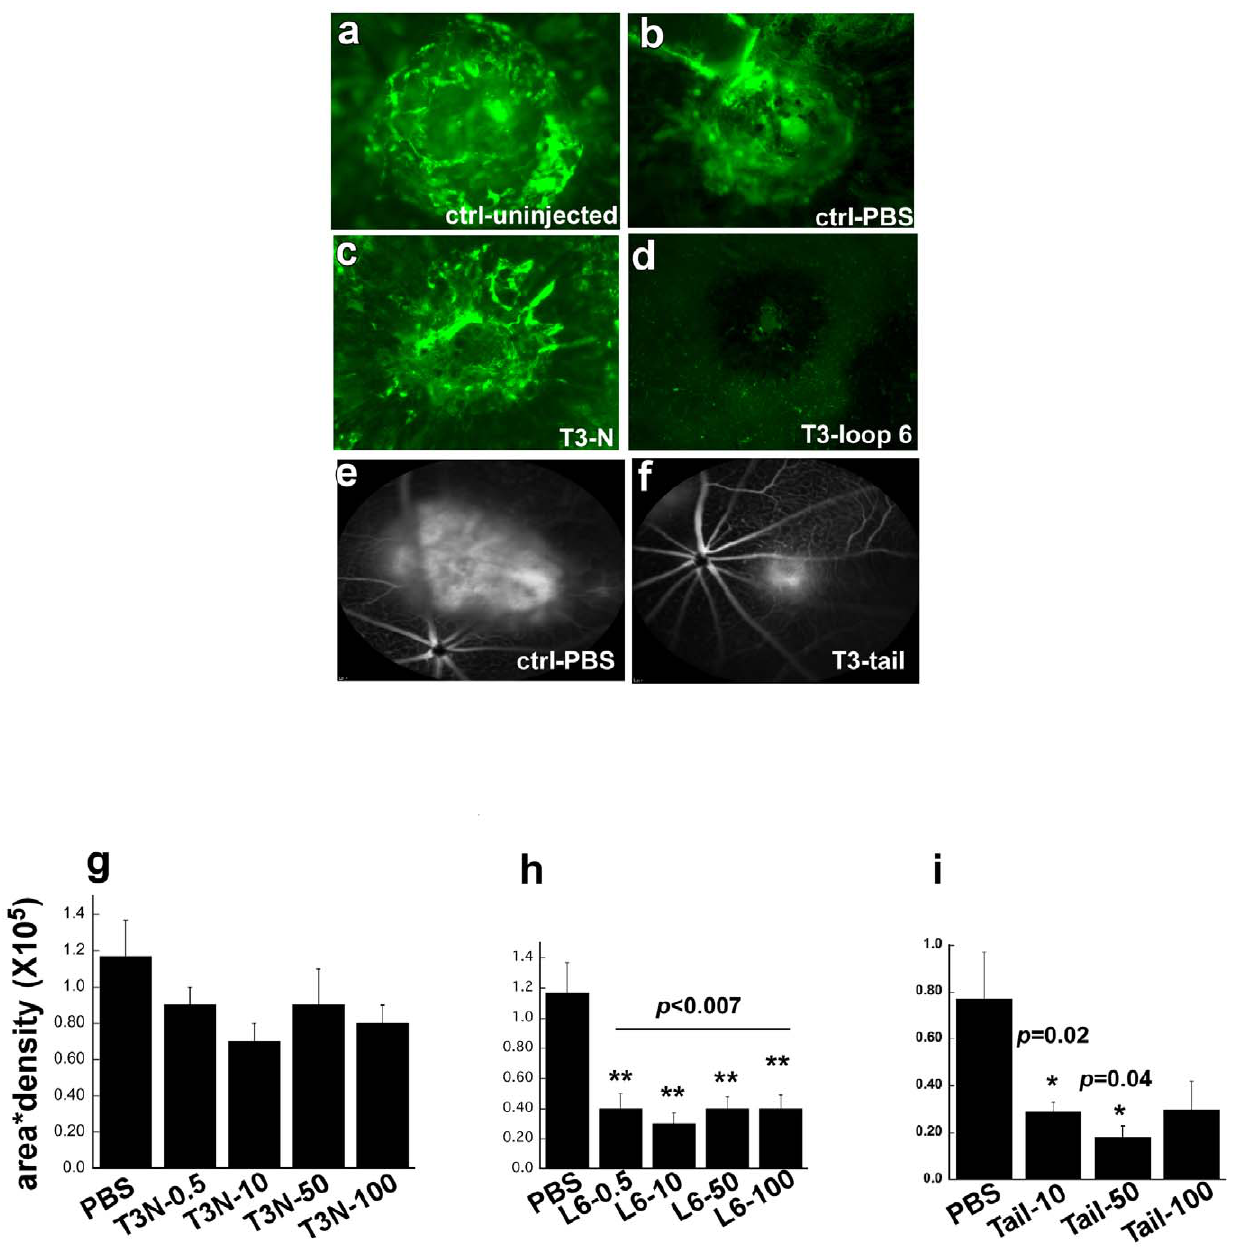
Figure 7. Inhibition of laser-induced CNV by TIMP-3 peptides. TIMP-3 loop 6 and tail but not N-peptide inhibit laser-induced CNV in a mouse model. Representative images of mouse choroids at 14 days following laser photocoagulation in C57BL6 mice (a) untreated/uninjected (b) injected with PBS control (c) T3N (d) T3-Loop6 (e) injected with PBS contro (f) T3-tail. Effect of Tail peptides on CNV was evaluated by Fluorescein angiogram and Scanning Laser Ophthalmoscopy (SLO). Peptides were injected intravitreally immediately following laser burn. CNV lesion size (area X density) was calculated for each dose of T3N-peptide (Fig. 7g), Loop6-peptide (Fig. 7h) and Tail-peptide (fig. 7i).